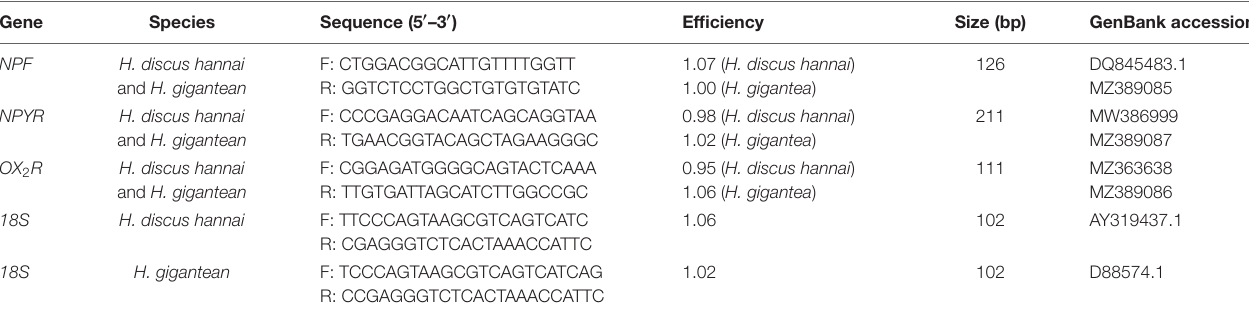
TABLE 1 | Real-time quantitative PCR primers used for feeding-related genes in Haliotis discus hannai and Haliotis gigantea .